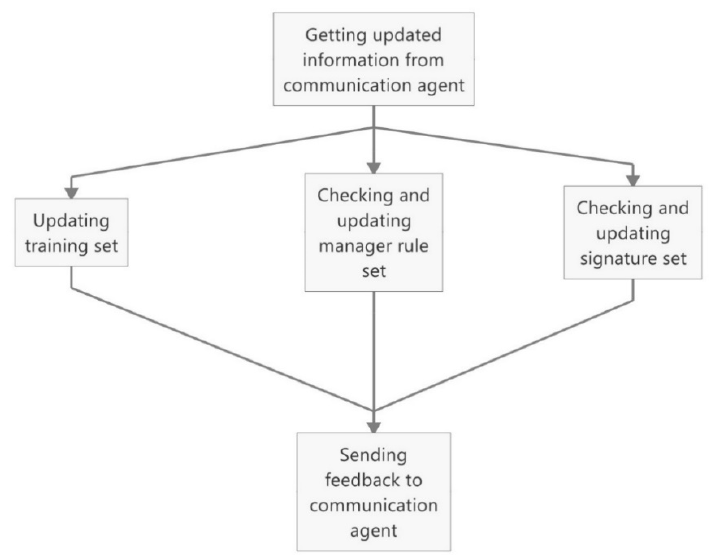
Figure 6. Process of database agent.